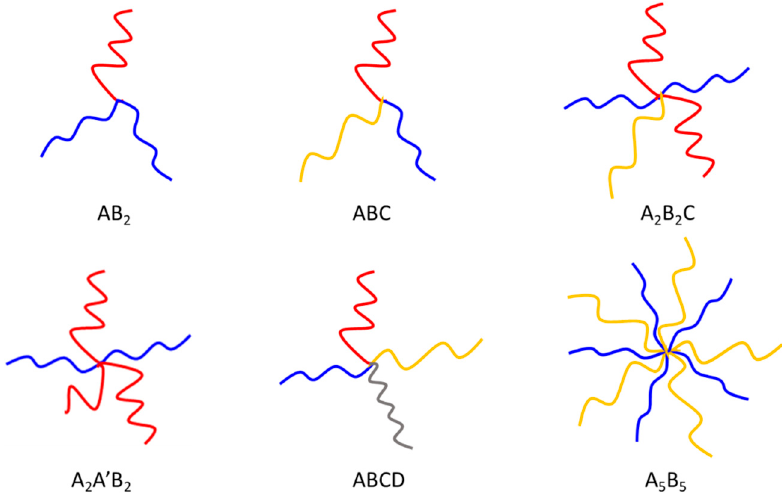
Figure 1. Miktoarm polymer architectures of varied compositions.